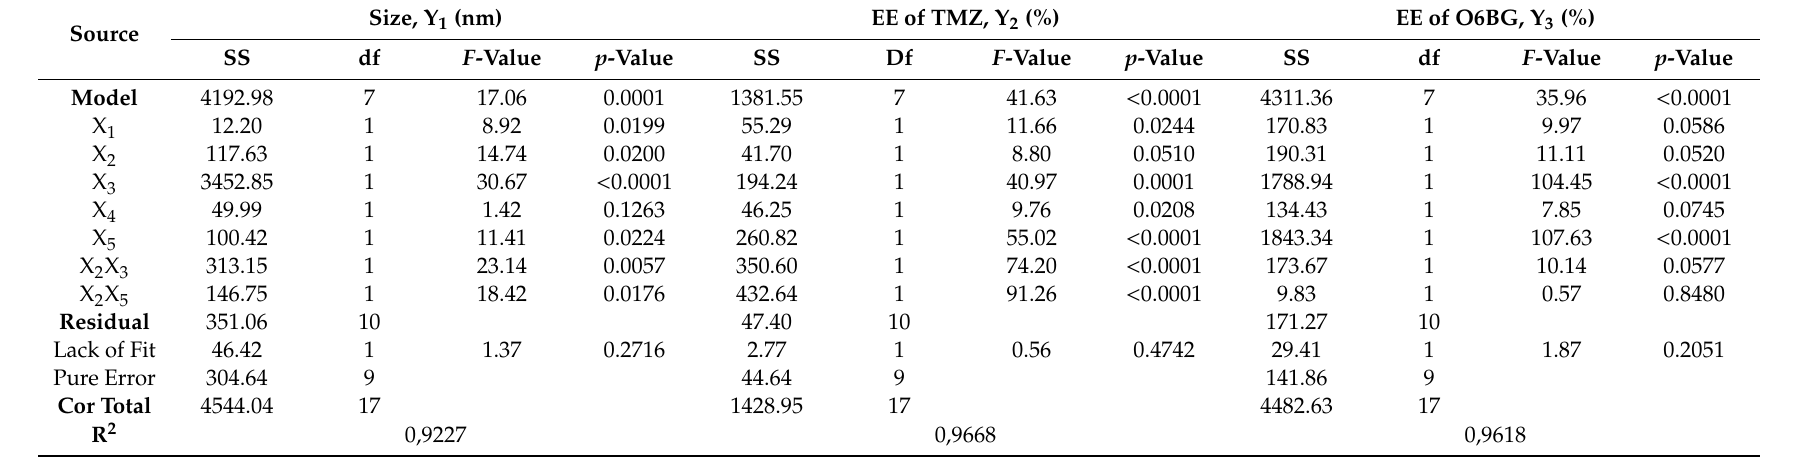
Table 3. Results of analysis of variance (ANOVA) for the regression models. Non-significant factors are marked as